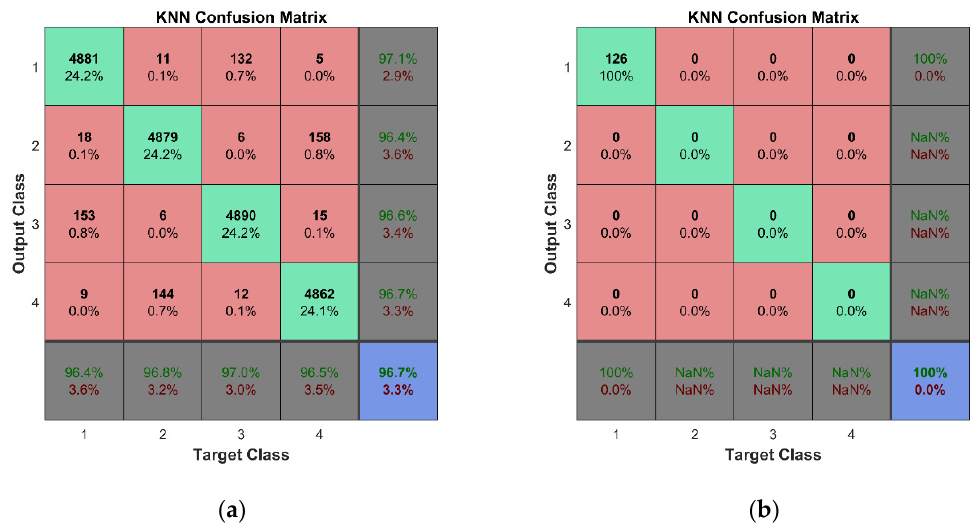
Figure 23. Classification results for the second learning scheme: ( a ) cross-validation results; ( b ) predictive performance on unseen experimental data.